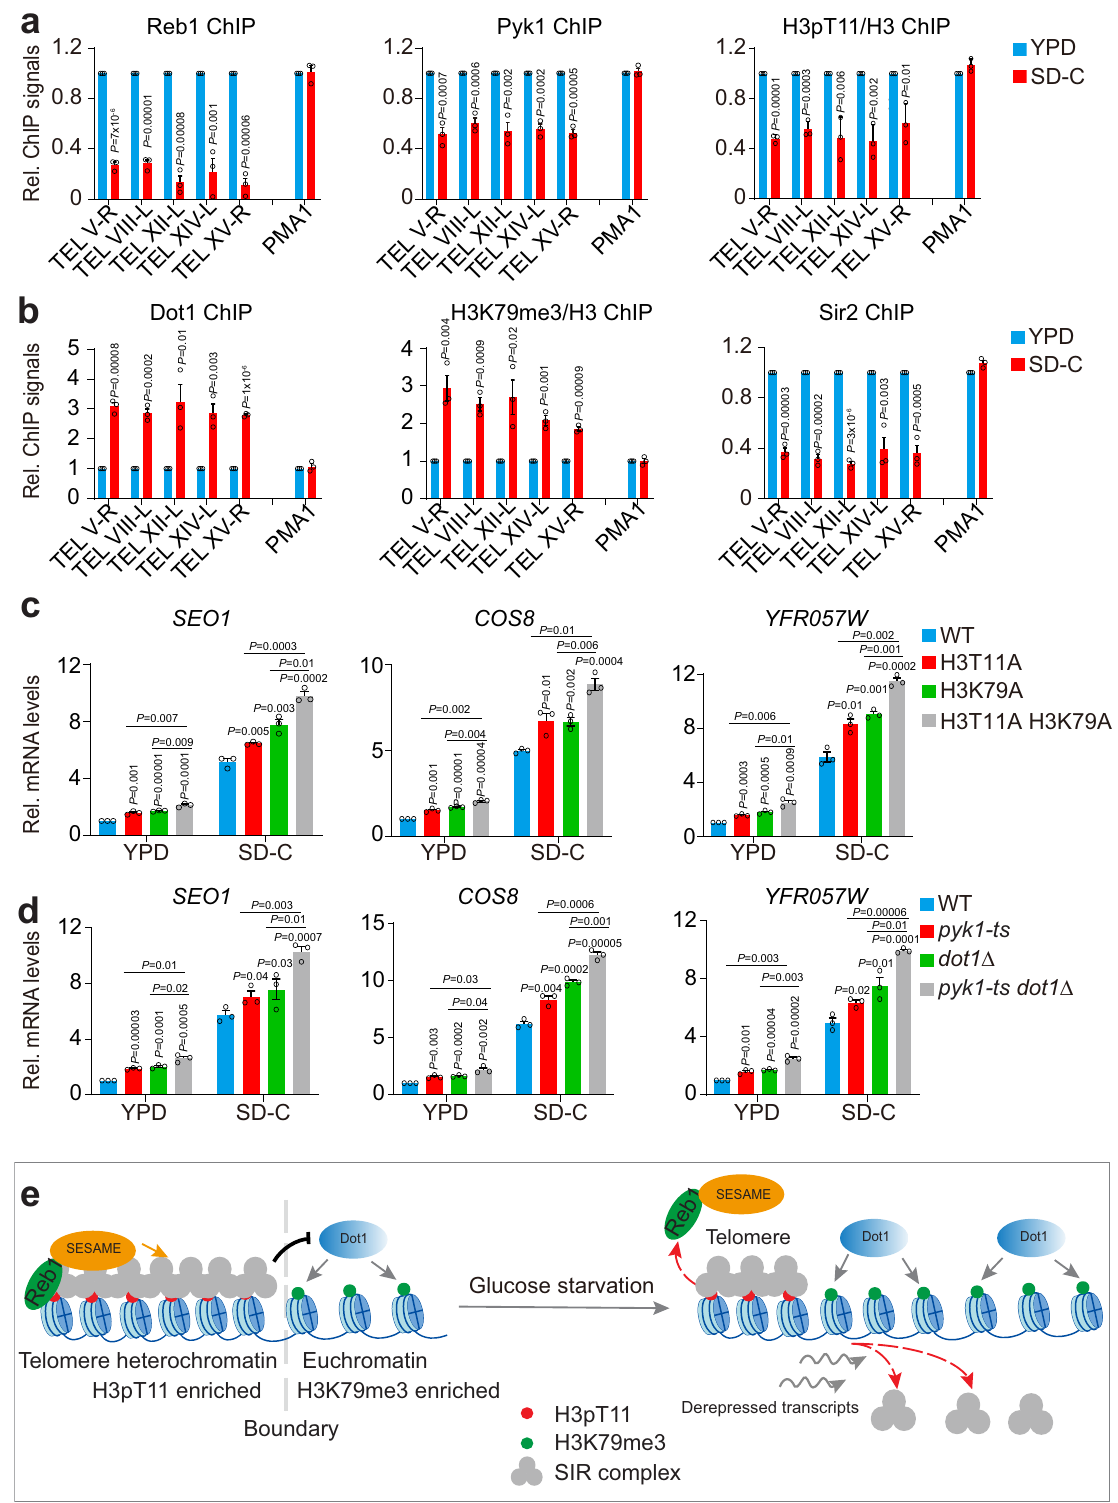
Fig. 8 | H3pT11 and H3K79me3 work together to regulate telomere silencing duringglucosestarvationconditions.a ChIP-qPCRanalysisoftheenrichmentof Reb1, Pyk1 and H3pT11/H3 attelomere-proximal regions when cells were grown in YPD and SD-C medium, respectively. Yeast cellswere grown in YPD until OD 600 of 1.0. Cells were harvested, resuspended in SD-C and then grown for 3h. b ChIP- qPCR analysis of the enrichment of Dot1, H3K79me3/H3, and Sir2 at telomere- proximal regions when cells were grown in YPD and SD-C medium, respectively. c RT-qPCR analysis of the transcription of telomere-proximal genes ( SEO1 , COS8 ,